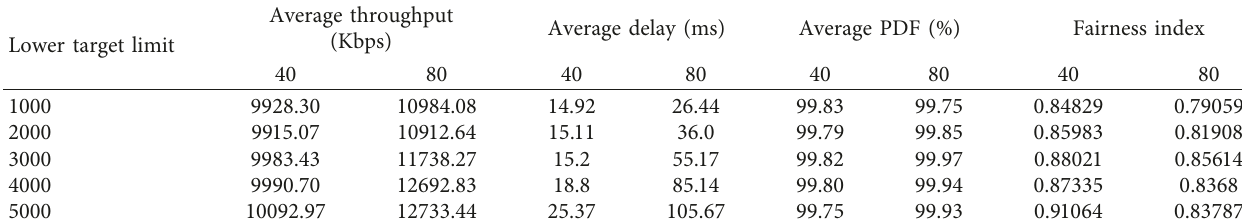
Table 3: Performance of the system for varying lower target limit of cwnd.